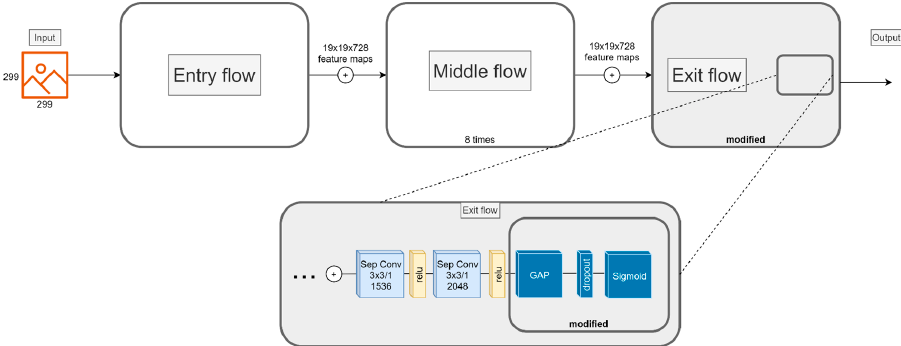
Figure 8. Exit flow blocks modified in the proposed model.